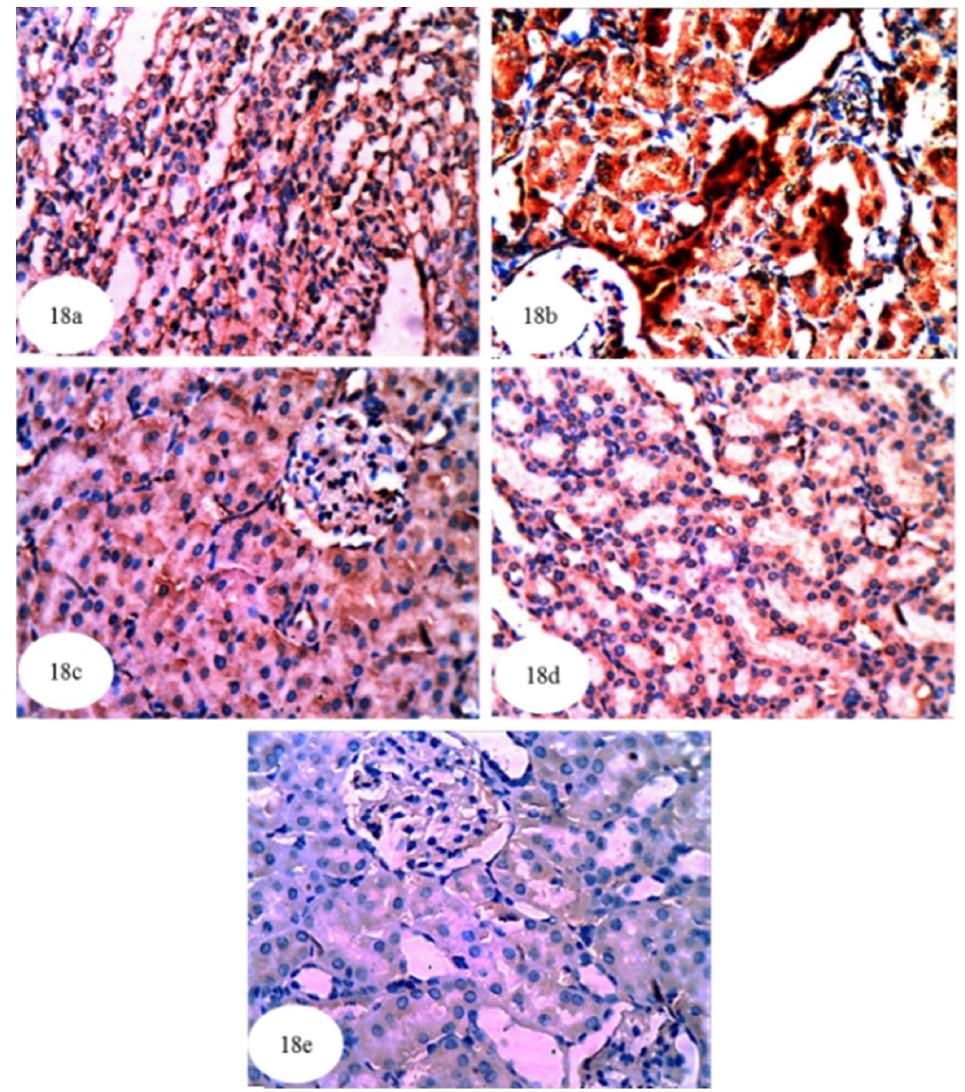
Figure 18. Photomicrographs ( a – e ) of immunohistochemically stained kidney sections showing the greater amount of the apoptotic marker p53 (yellowish brown color) in the cytoplasm and nuclei of the hyperoxaluric control rats ( b ) (×384) as compared with normal control group ( a ) (×384). The p53 was remarkably decreased after treatment of ethylene glycol-administered rats with P. ostreatus ( c ) (×384) and A. bisporus ( d ) (×384) infusions and carvedilol ( e ) (×384), which was indicated by decline of the intensity of yellowish brown color.